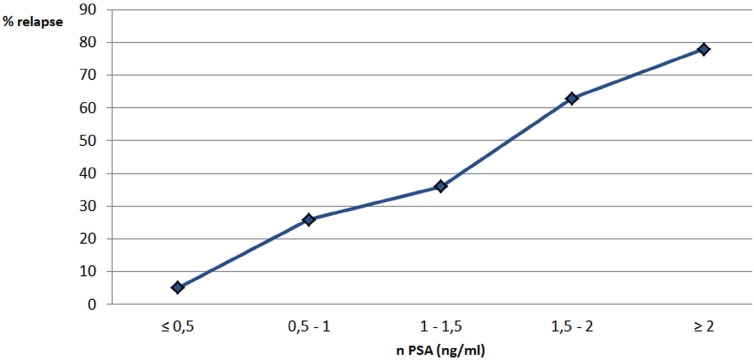
% relapse compared to nPSA level. Patients attaining a low PSA nadir have a significantly improved BFFF. When we compare the 5 year biochemical free survival in patients based on the PSA nadir, there is an almost linear correlation between the nadir and the relapse rate.